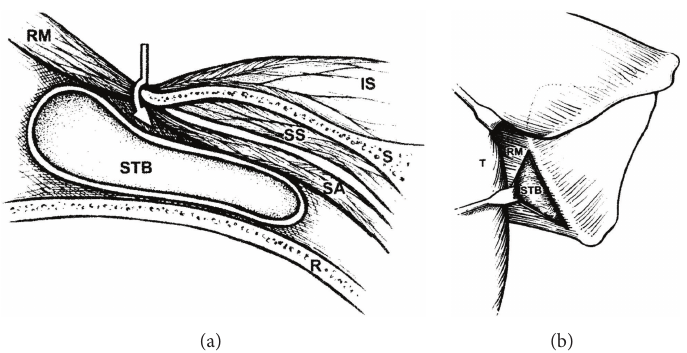
Figure 2: (a) Drawing of cross-sectional anatomy. The arrow shows the plane of dissection between the rhomboid major (RM) and the medial scapula (S), which allows access to the scapulothoracic bursa (STB). This bursa is in the space between the serratus anterior (SA) muscle and rib cage (R). IS, infraspinatus, (IS); SS, subscapularis. (b) Drawing of posterior view. The inferior trapezius (T) is retracted, exposing the rhomboid major (RM) muscle. The rhomboid major muscle is retracted, exposing the scapulothoracic bursa (STB), thus confirming the proper dissection plane (drawings reproduced from Nicholson and Duckworth (2002) with permission of Elsevier B.V.).